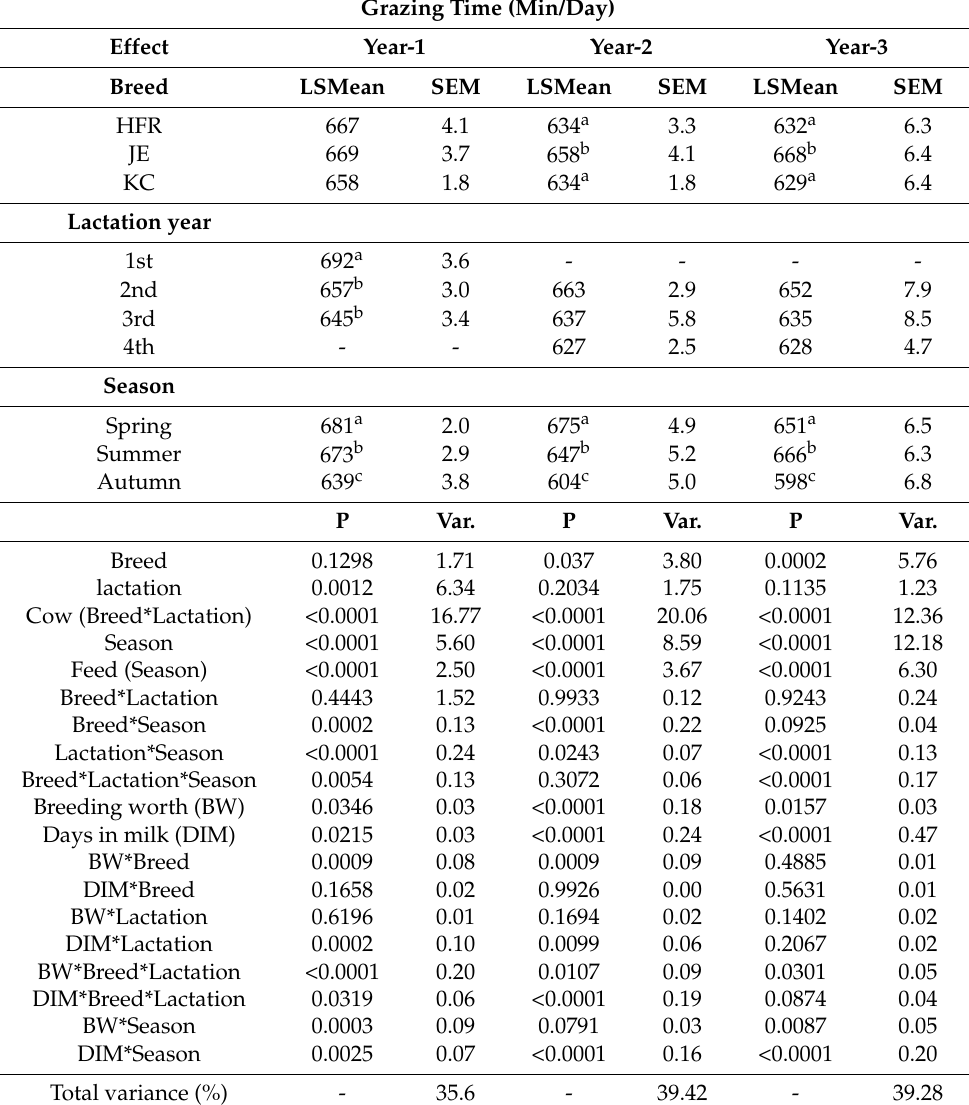
Table 2. Least square means (LSMean) and standard errors of means (SEM) of grazing time (min/day) for the effects of breed, lactation year and season, and p values and the variance (%) explained by breed, lactation year, cow within breed and lactation year, season, feed within the season, breeding worth (BW) index, days in milk (DIM), and their interactions in three consecutive years of the study period using a mixed effects model with the cow ( n = 54 ) as a random factor, and BW and DIMas continuous